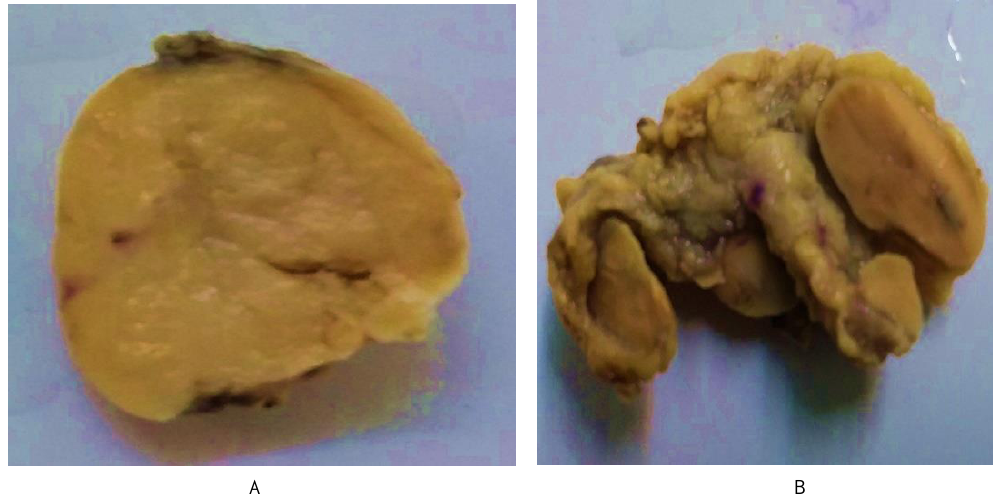
Fig. 1. A. Macroscopic examination show an encaspulated tan nodular mass resembling lymphoid tissue. B. Macroscopic examination show an encapsuated tan nodular mass resembling lymphoid tissue